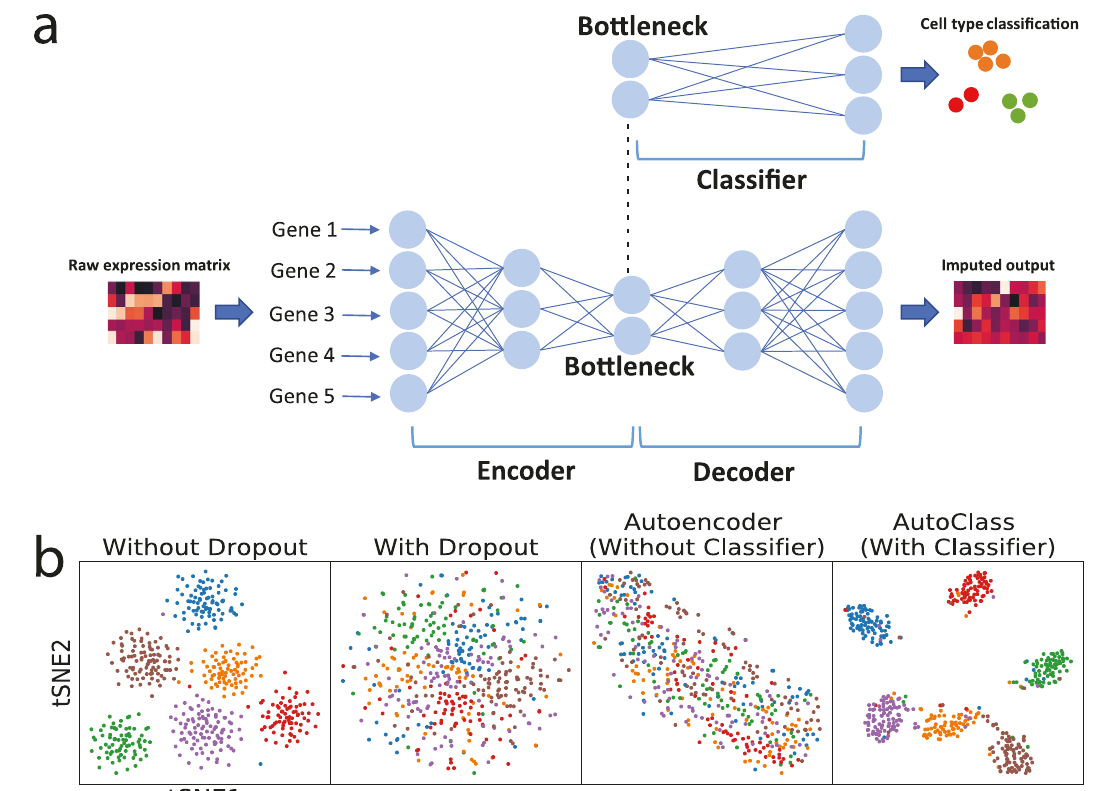
Fig. 1 AutoClass integrates a classi fi er to a regular autoencoder, as to fully reconstruct scRNA-Seq data. a AutoClass consists a regular autoencoder and a classi fi er branch from the bottleneck layer. The input raw expression data is compressed in the encoder, and reconstructed in the decoder, the classi fi er branch helps to retain signal in data compression. The output of the autoencoder is the desired imputed data (see “ Methods ” for details). b t-SNE plots of Dataset 1 without dropout, with dropout, with dropout imputed by a regular autoencoder and